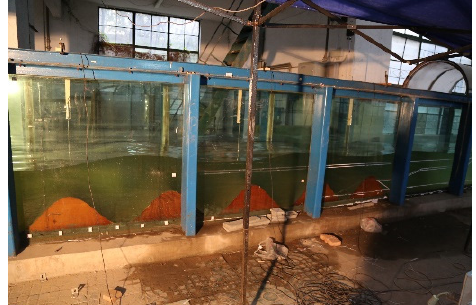
Figure 6. Five fixed continuous sinusoidal wavy bottoms installed in flume.